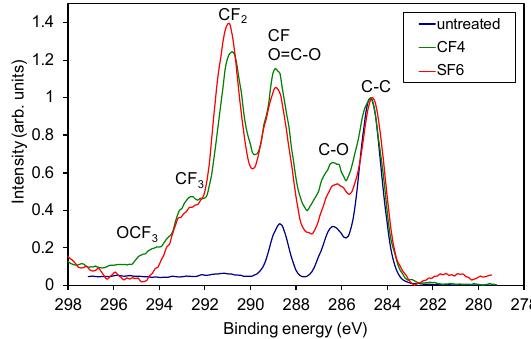
Figure 5. Comparison of selected high-resolution C 1s spectra of the untreated PET sample and the plasma-treated samples in the first region, below the threshold pressure.